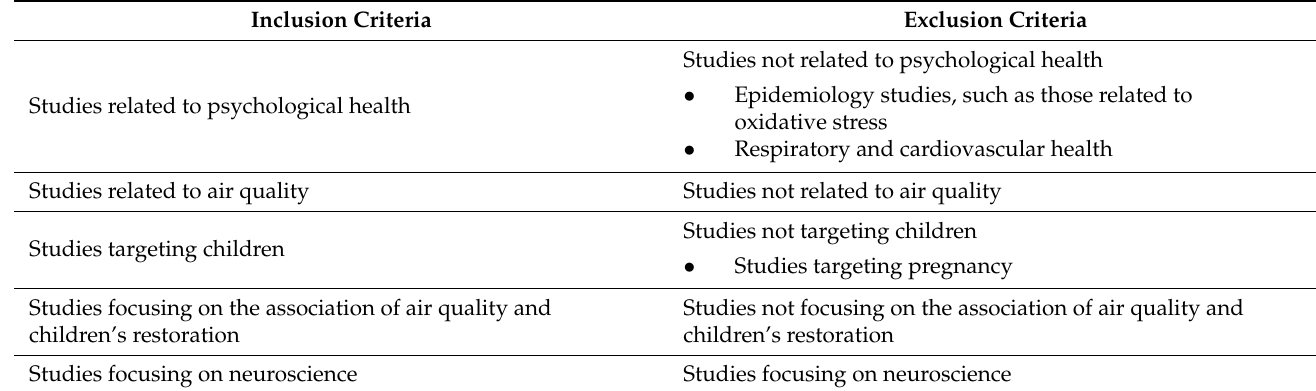
Table 2. Inclusion and Exclusion